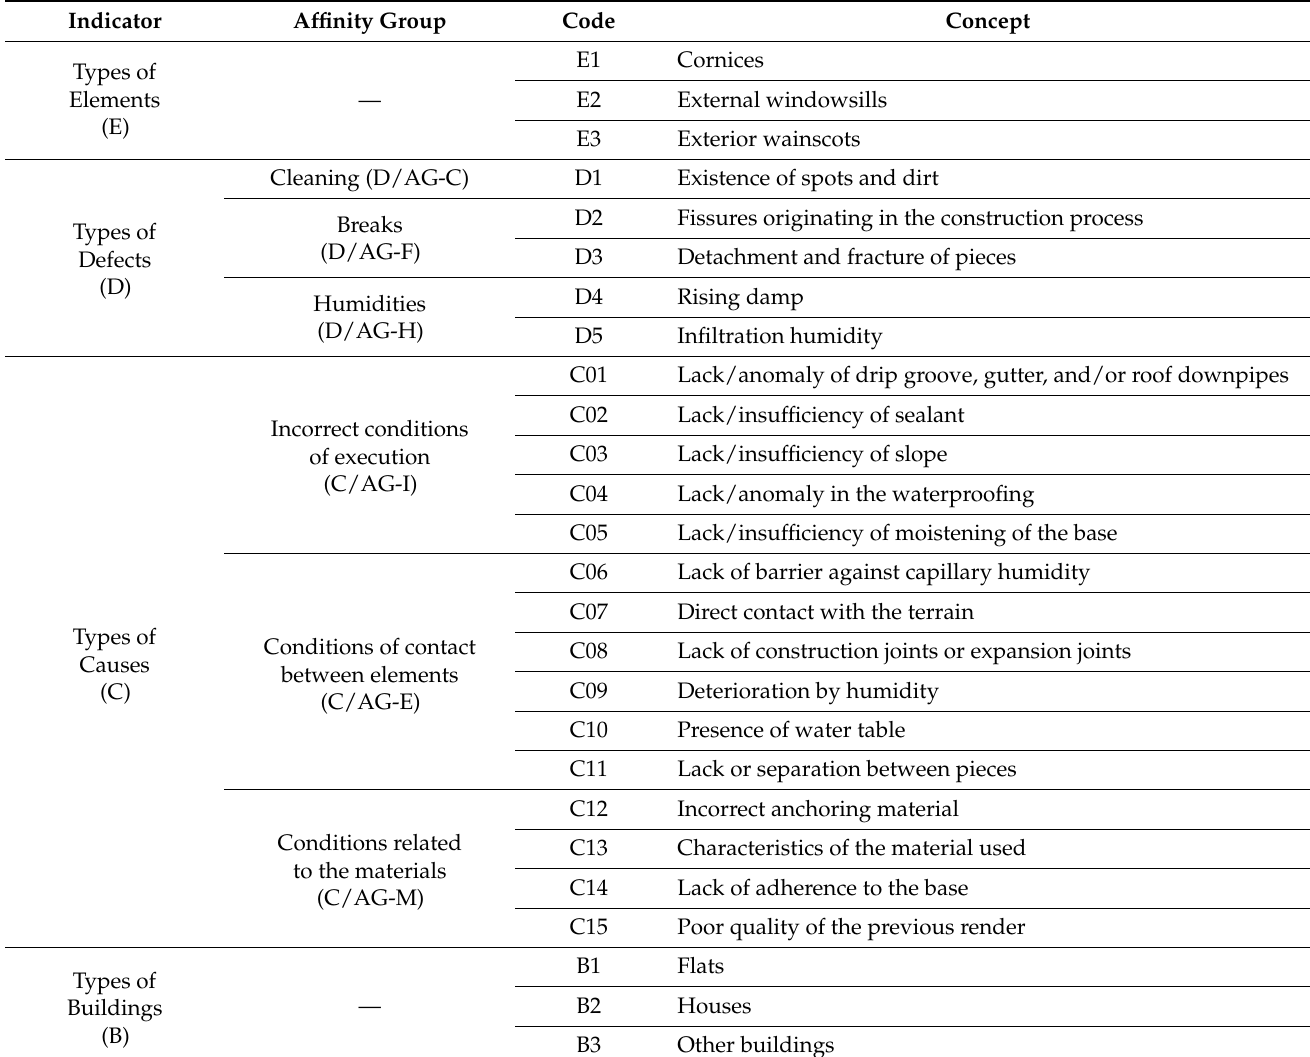
Table 1. Classification of the indicators, their affinity groups, and the underlying